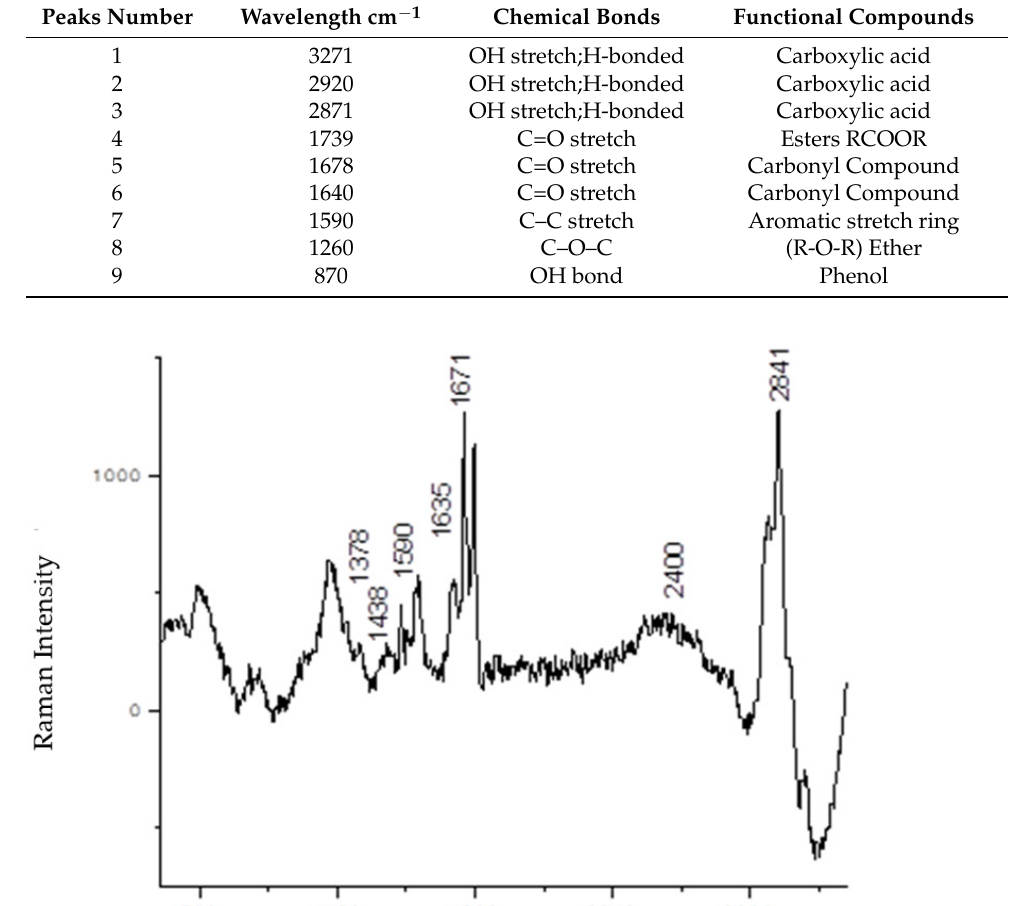
( b ) Figure 2. ( a ) The Raman spectrum ( b ) FTIR spectrum of ginger essential oil.